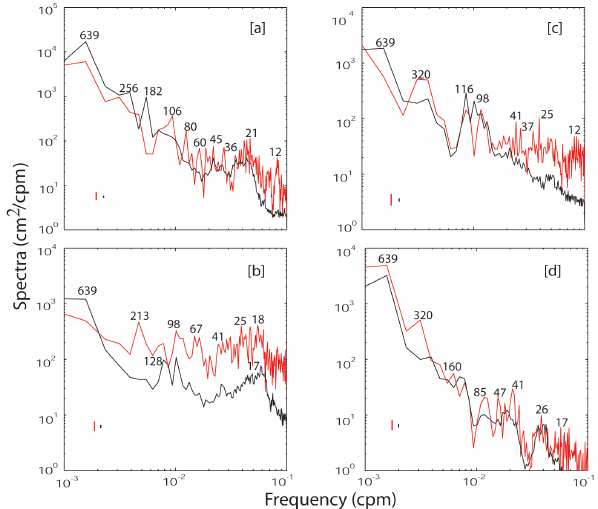
Figure 11. Spectrum of sea level residual (SLR) during E2 at (a) Gopalpur, (b) Gangavaram, (c) Kakinada and (d) Port Blair. The data duration for estimating the spectrum of the SLR dur- ing E2 (background) is 25–31 December (1 September–10 Decem- ber) 2011. Vertical red (black) line shows the 95% confidence inter- val of the event(background) spectrum for the respective